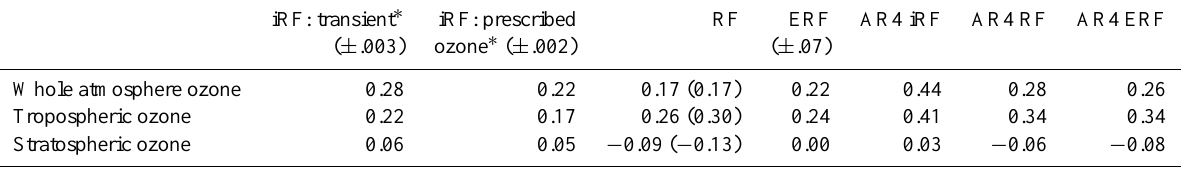
Table 4. Global mean annual average 1850 to 2000 ozone radiative forcings (Wm − 2 )